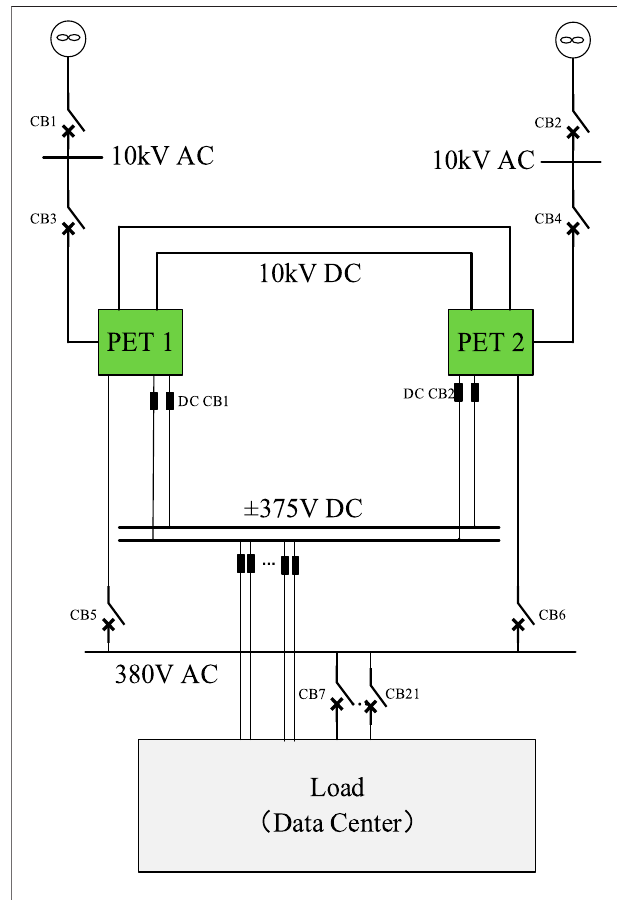
FIGURE 13 | Electrical schematic diagram of power system demonstration site in the data